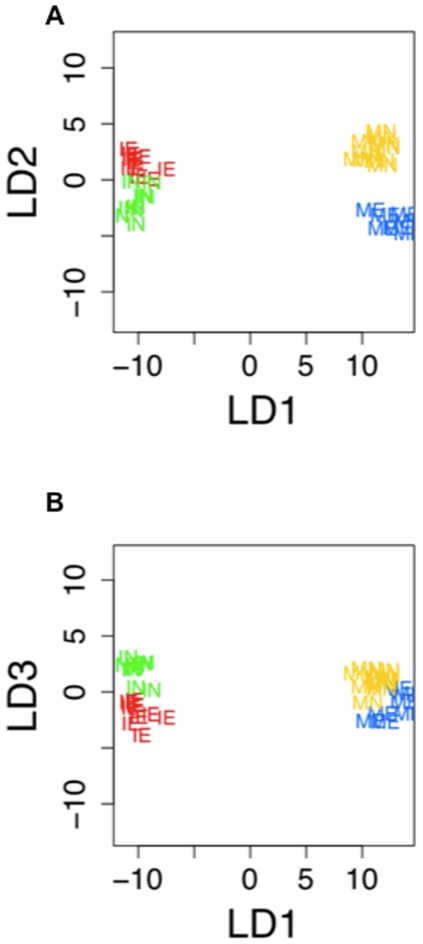
Plot of linear discriminant (LD) scores.“IN”: immature and naïve; “IE”: immature having encountered a female; “MN”: mature and naïve; “ME”: mature with courtship experience. A) LD1 vs. LD2. B) LD1 vs. LD3.